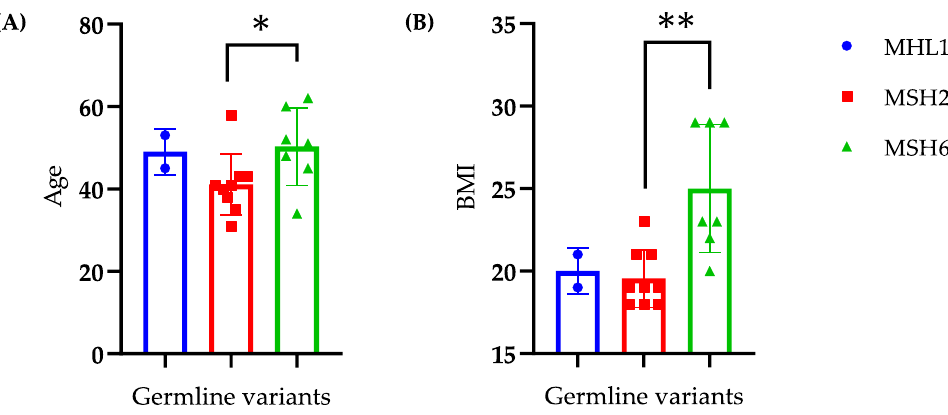
Figure 2. Correlation between the classes of germline variants ( MLH1 , MSH2 , MSH6 ) and clinical features of Lynch Syndrome patients: age ( A ), BMI ( B ). Data are presented as mean ± SD. Statistical significance is specified with asterisks. ( p < 0.05 *, p < 0,01 ** as determined by an unpaired Student’s t -test). MLH1 : MutL homolog 1 ; MSH2 : MutS homolog 2; MSH6 : MutS homolog 6; BMI: body mass index.